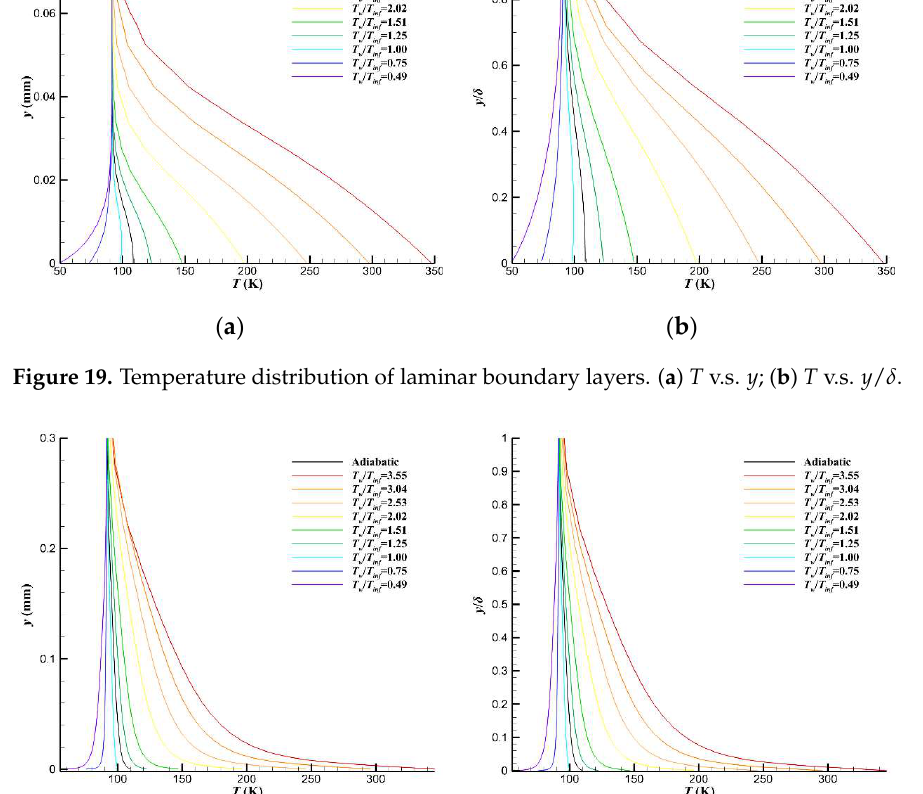
Figure 21. Turbulent kinetic energy distribution of different temperature gradient. ( a ) k v.s. y ; ( b ) k v.s. y/δ